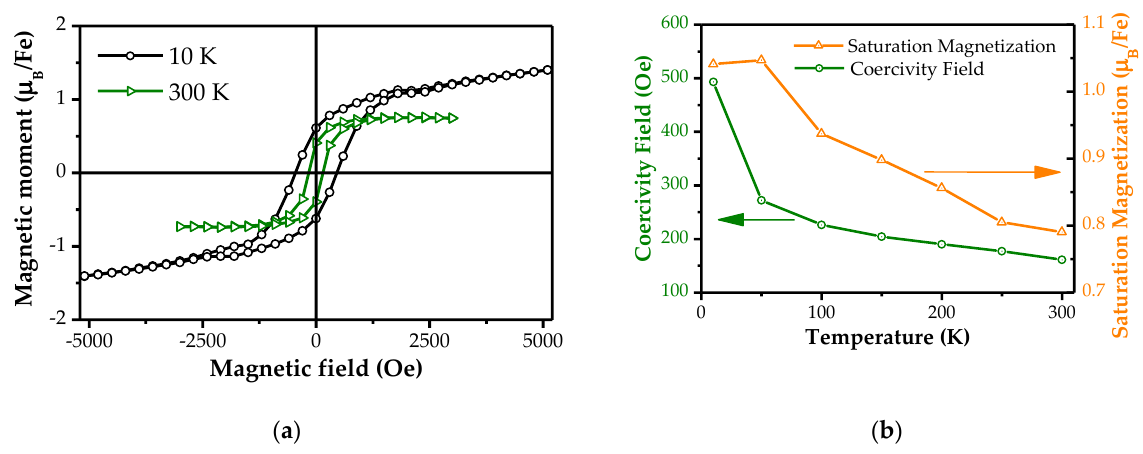
Figure 3. Magnetometry studies of Fe-ion implanted MgO: ( a ) in-plane magnetization curves of the sample; ( b ) temperature dependence of hysteretic component parameters H c and M s . Magnetization values are given per implanted iron atom.